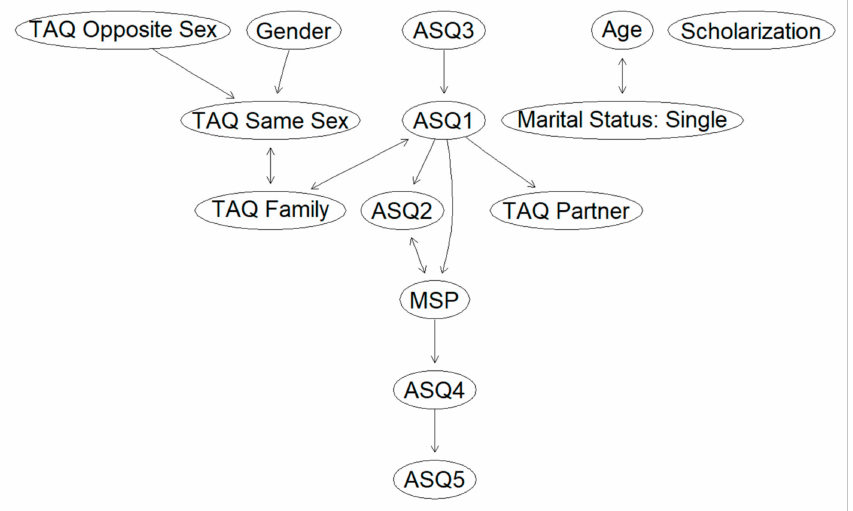
Figure 2. Directed network of the variables’